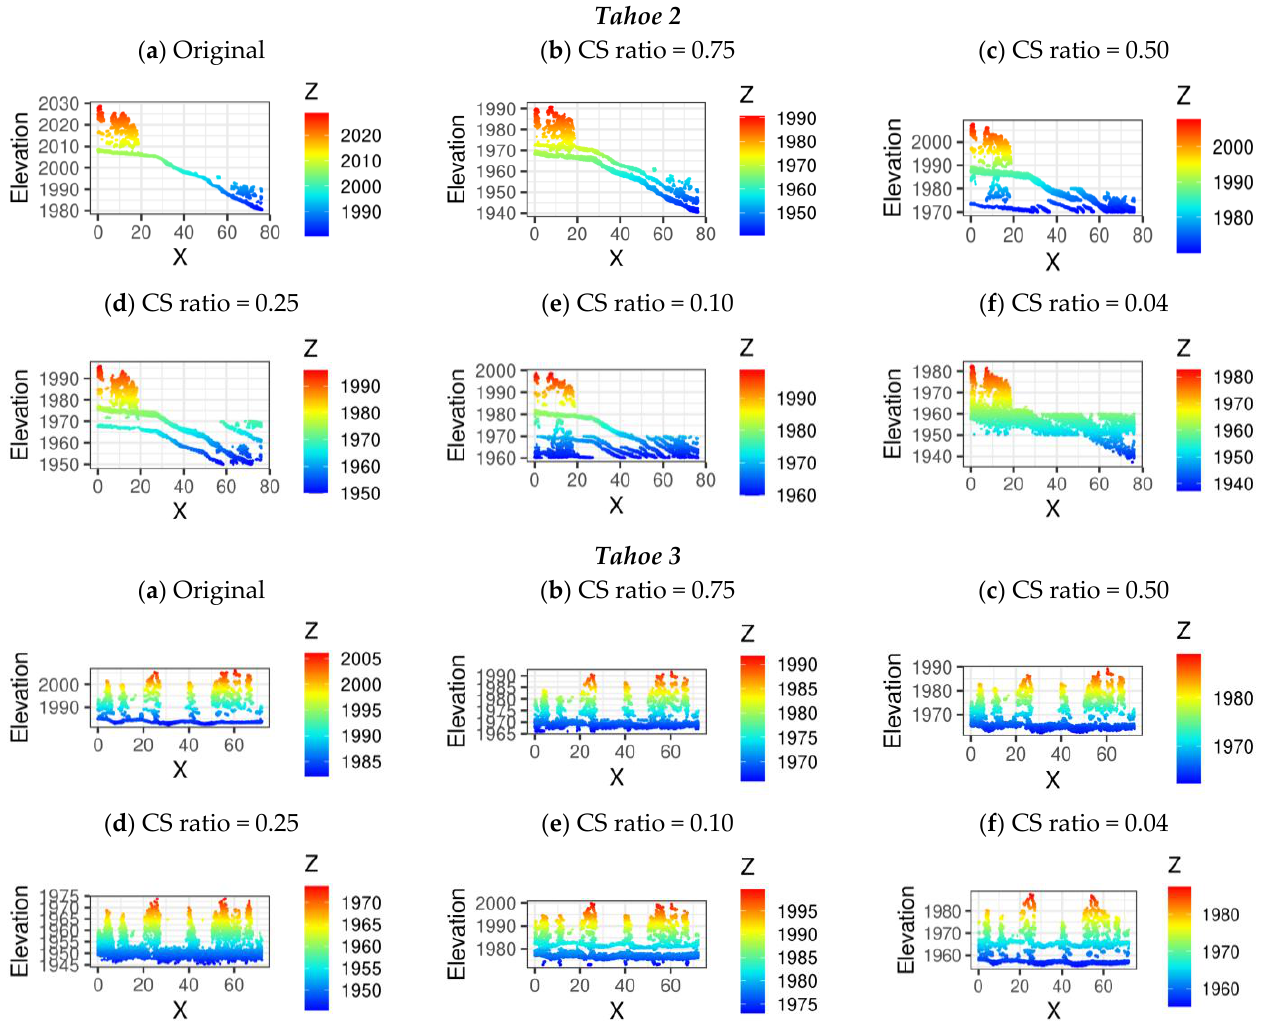
Figure 12. Visualization of the vertical elevation (2D cross-section) profiles of the subset of the original and reconstructed 3D LiDAR point clouds using the proposed ADCoSNet for the selected Andrews 1, Andrews 2, Tahoe 1, Tahoe 2, and Tahoe 3 test sites. ( a ) Original; ( b ) CS Ratio = 0.75; ( c ) CS Ratio = 0.50; ( d ) CS Ratio = 0.25; ( e ) CS Ratio = 0.10; ( f ) CS Ratio = 0.04. Table 3. Ablation Study for Multivariate Empirical Mode Decomposition as a basis transform for CS-based reconstruction using the proposed ADCoSNet framework (Overall PSNR in dB for Tahoe 1 with CS measurement ratio of 0.75). Proposed Architecture Without MEMD With MEMD ADCoSNet 40.94 dB 48.96